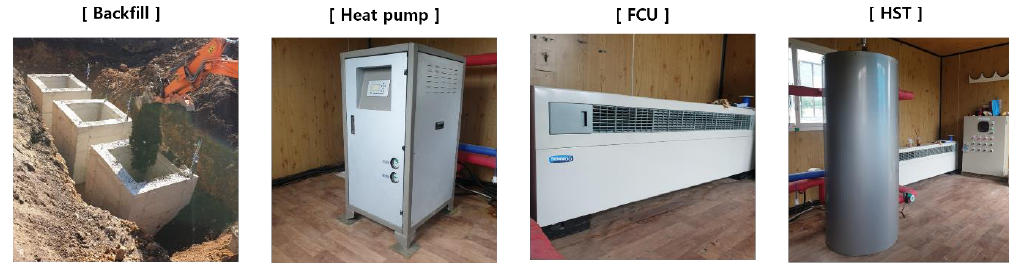
Figure 10. Backfill and experiment equipment. Table 7. Specifications of the components in the Table 6. Experiment conditions.